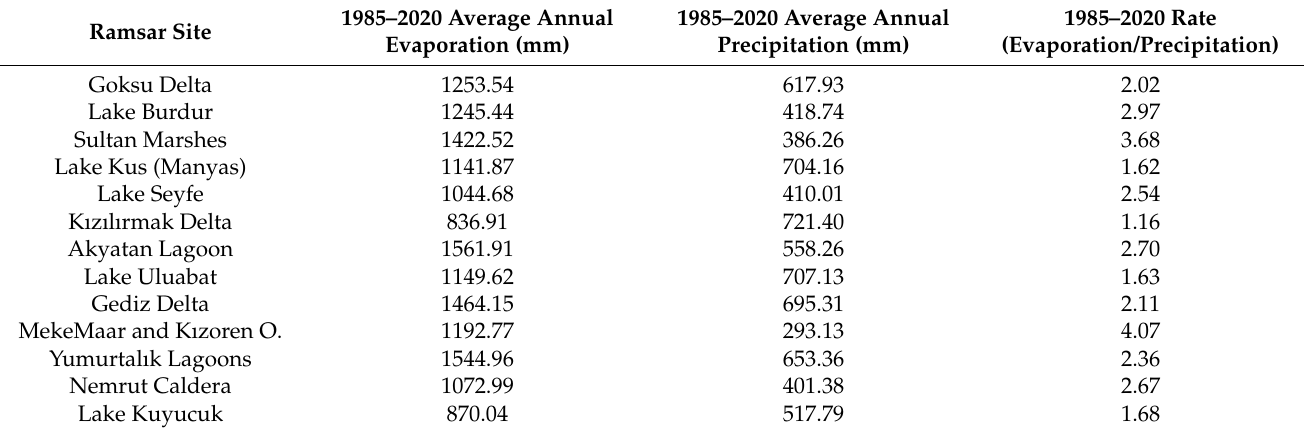
Table 6. Average precipitation and evaporation of 13 meteorological stations for 1985 to